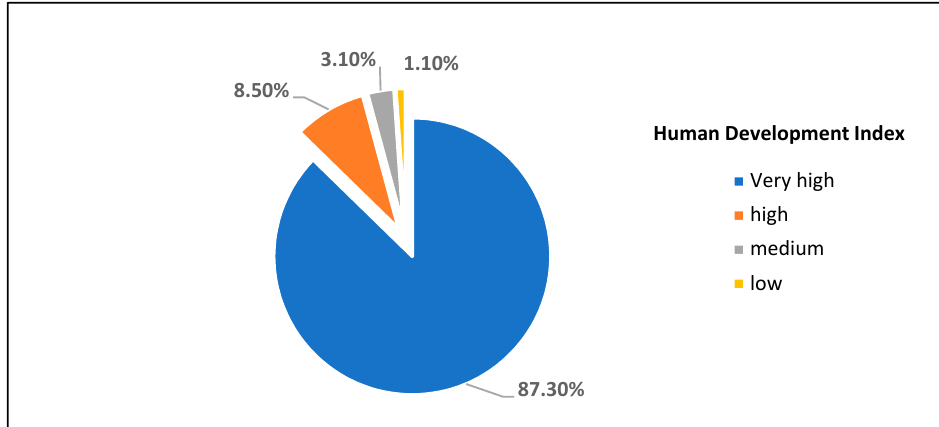
Figure 2. Number of respondents by human development index.